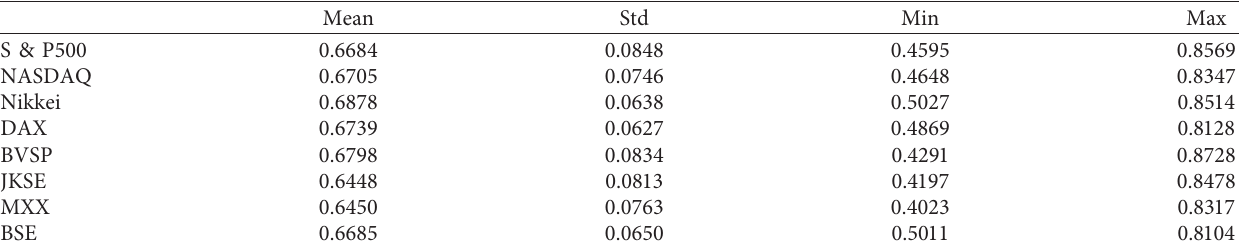
Figure 6: The dynamic evolution of the cross-correlation between financial market return and online sentiment in developing countries ( q � 2): (a) Brazil: BRL, (b) Indonesia: Jakarta, (c) Mexico: MXX, (d) India: BSE. Table 3: Statistical characteristics of dynamic cross-correlation between financial markets return and online sentiment. Mean Std Min